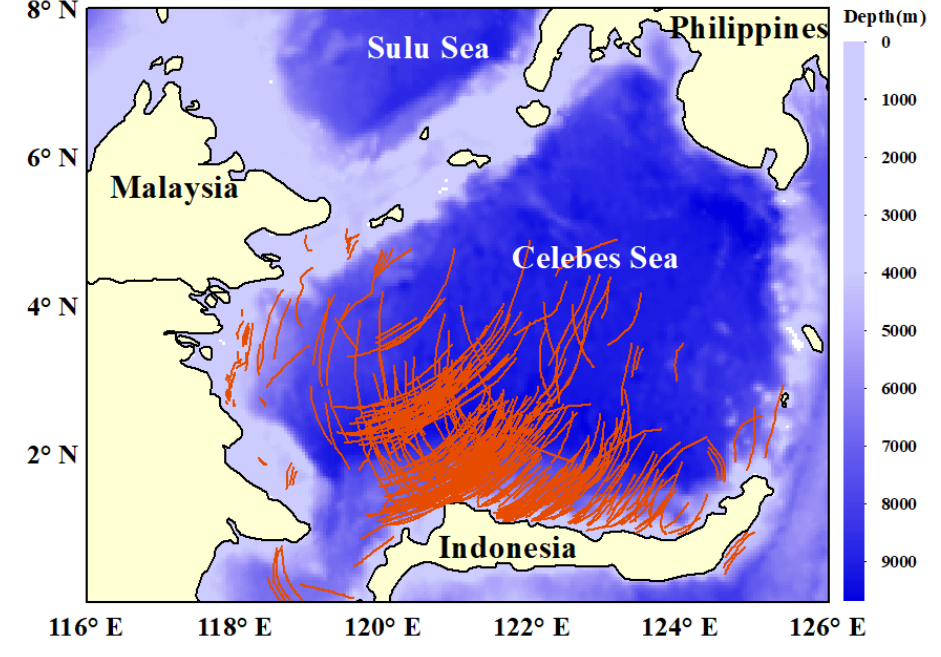
Figure 1. Spatial distribution of internal waves in the Celebes Sea, which are extracted from MODIS images from 2017–2018 .